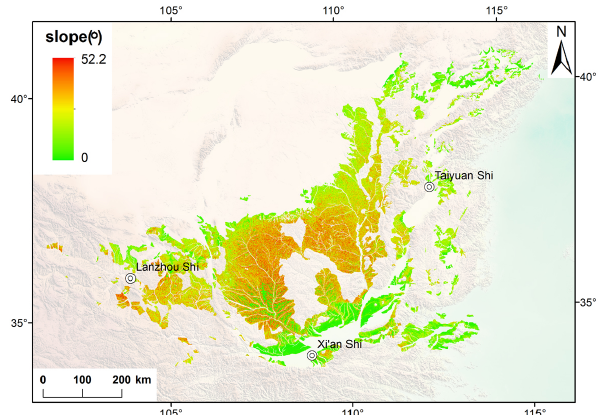
Figure 4. Slope distribution status in the typical loess geomorpho- logic area of the Loess Plateau.